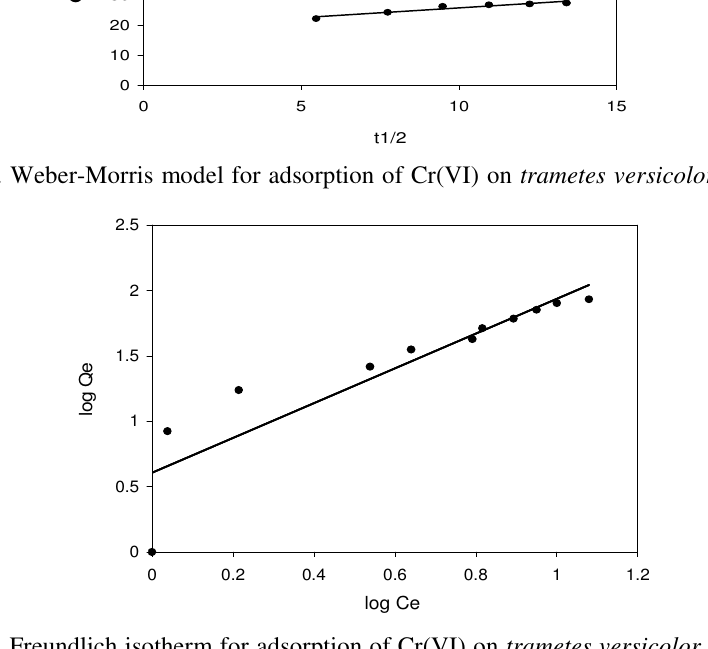
Figure 8 . Freundlich isotherm for adsorption of Cr(VI) on trametes versicolor polyporous